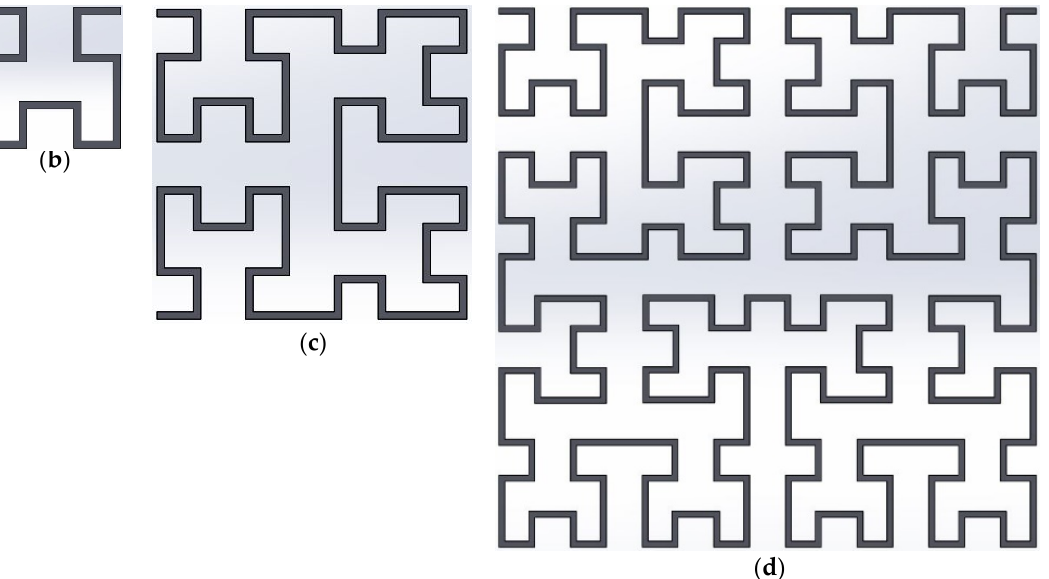
Figure 2. Generation of four iterations of Hilbert curves: ( a ) 1st iteration, ( b ) 2nd iteration, ( c ) 3rd iteration, ( d ) 4th iteration. The additional segments used to connect together copies of the previous iteration curves. First four fractal iterations for the Hilbert curve geometry. This indicates that for a given area, the total length of the line segments increases in near geometric progression, as the iteration order increases.